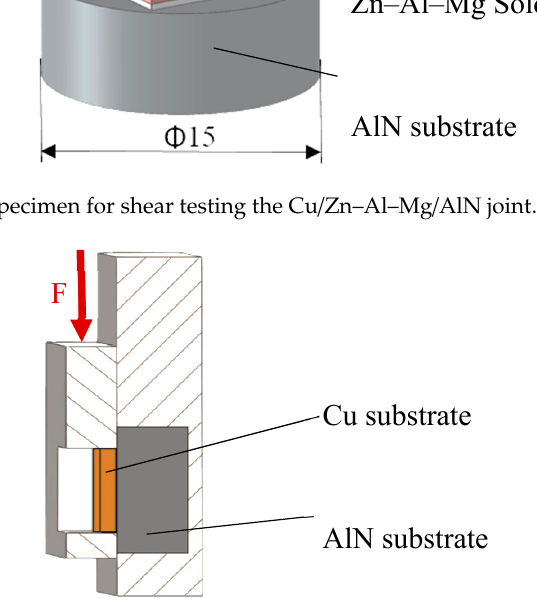
Figure 5. Scheme of shear strength measurement.